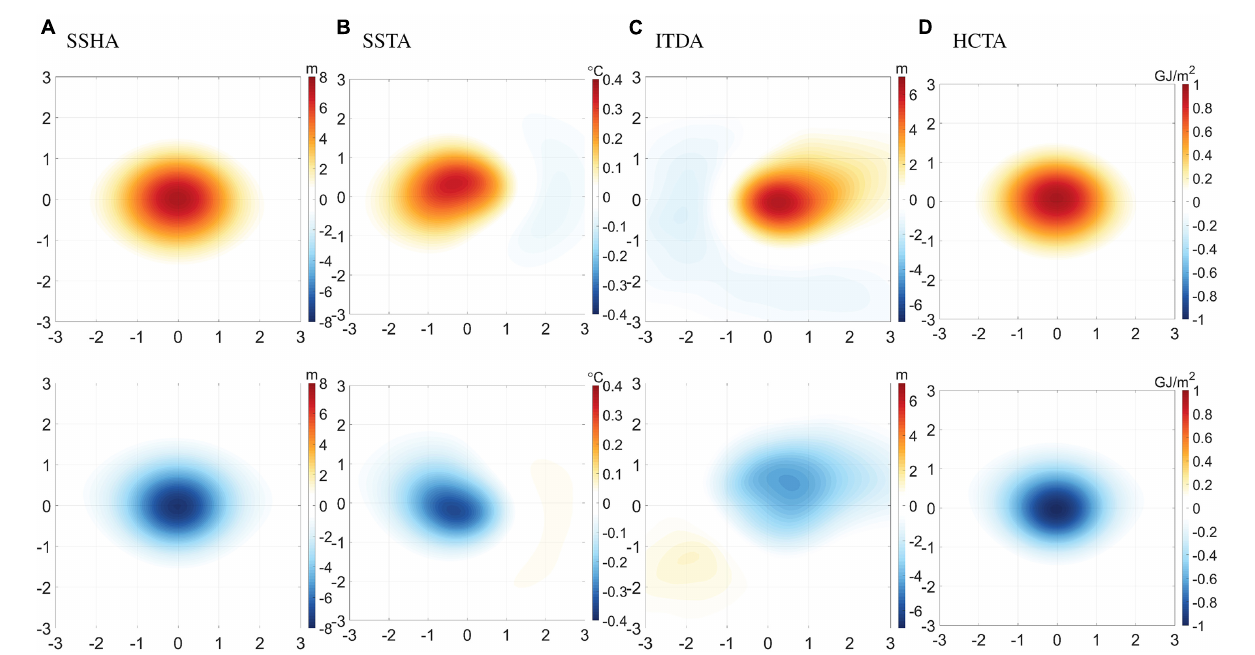
FIGURE 5 | Eddy-induced (A) SSHA (cm), (B) SSTA ( ◦ C), (C) ITDA (m), (D) HCTA (GJ/m 2 ) averaged over all eddies. The upper (lower) row is for anticyclonic (cyclonic) eddies. Eddies are scaled relative to their respective radius. Shown are the distribution of the indicated quantities within 3 times the eddy radius in each direction.